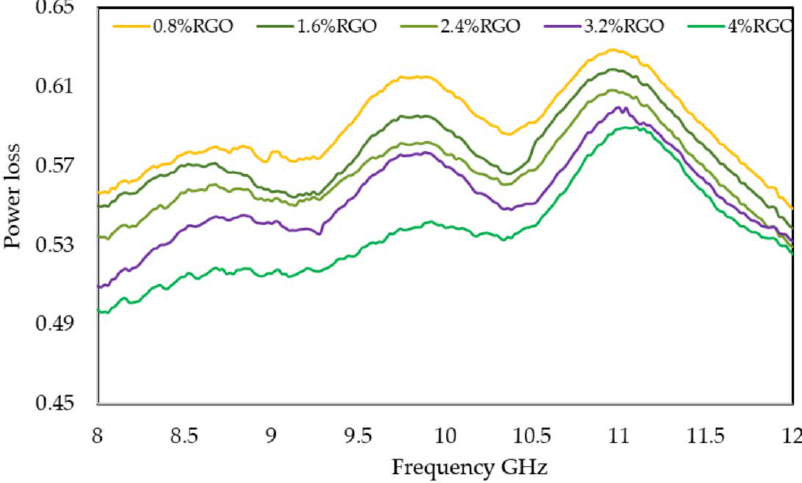
Polymers 2019 , 11 , x FOR PEER REVIEW Figure 13. Power loss versus RGO loading over the X band. Figure 13. Power loss versus RGO loading over the X band.